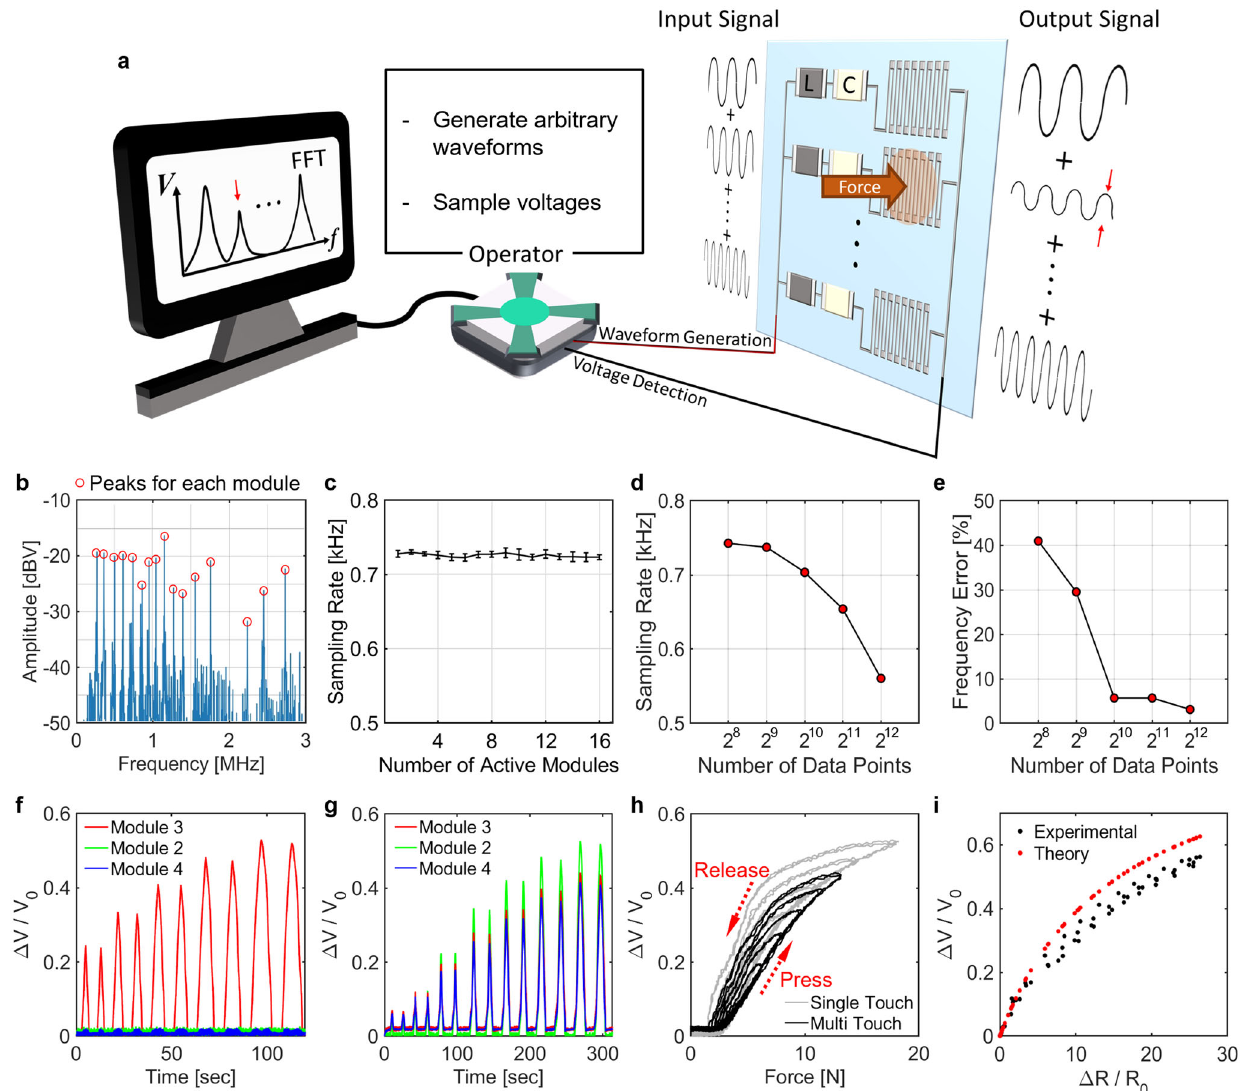
Fig. 2 Evaluation of sensing performance. a Conceptual drawing of sensor system con fi guration and operation schematic. b Sensor responses plotted in a frequency domain. Red circles show the 16 peaks of all the sensing modules. c Sampling rate vs. FFT sampling size for 16 sensing modules. d Frequency error in FFT as a function of the FFT sampling size for 16 sensing modules. e Sampling rate vs. the numbers sensing modules for an FFT sampling size of 1024. The error bars indicate standard deviations ( n = 5). f Sensor response for applied force to sensing module 3. Red line shows the response of the sensing module 3 and other lines are the responses of the adjacent modules (Modules 2 and 4). g Sensor responses for applied force to all the sensing modules. h Force to output voltage response of the sensing module 3 when a force is applied only to the sensing module 3 (gray), and the response of sensing module 3 when the force is applied to all the 16 modules (black). i Comparison of the theoretical prediction (red) and the experimental result (black) of the resistance change in the sensing module and the output